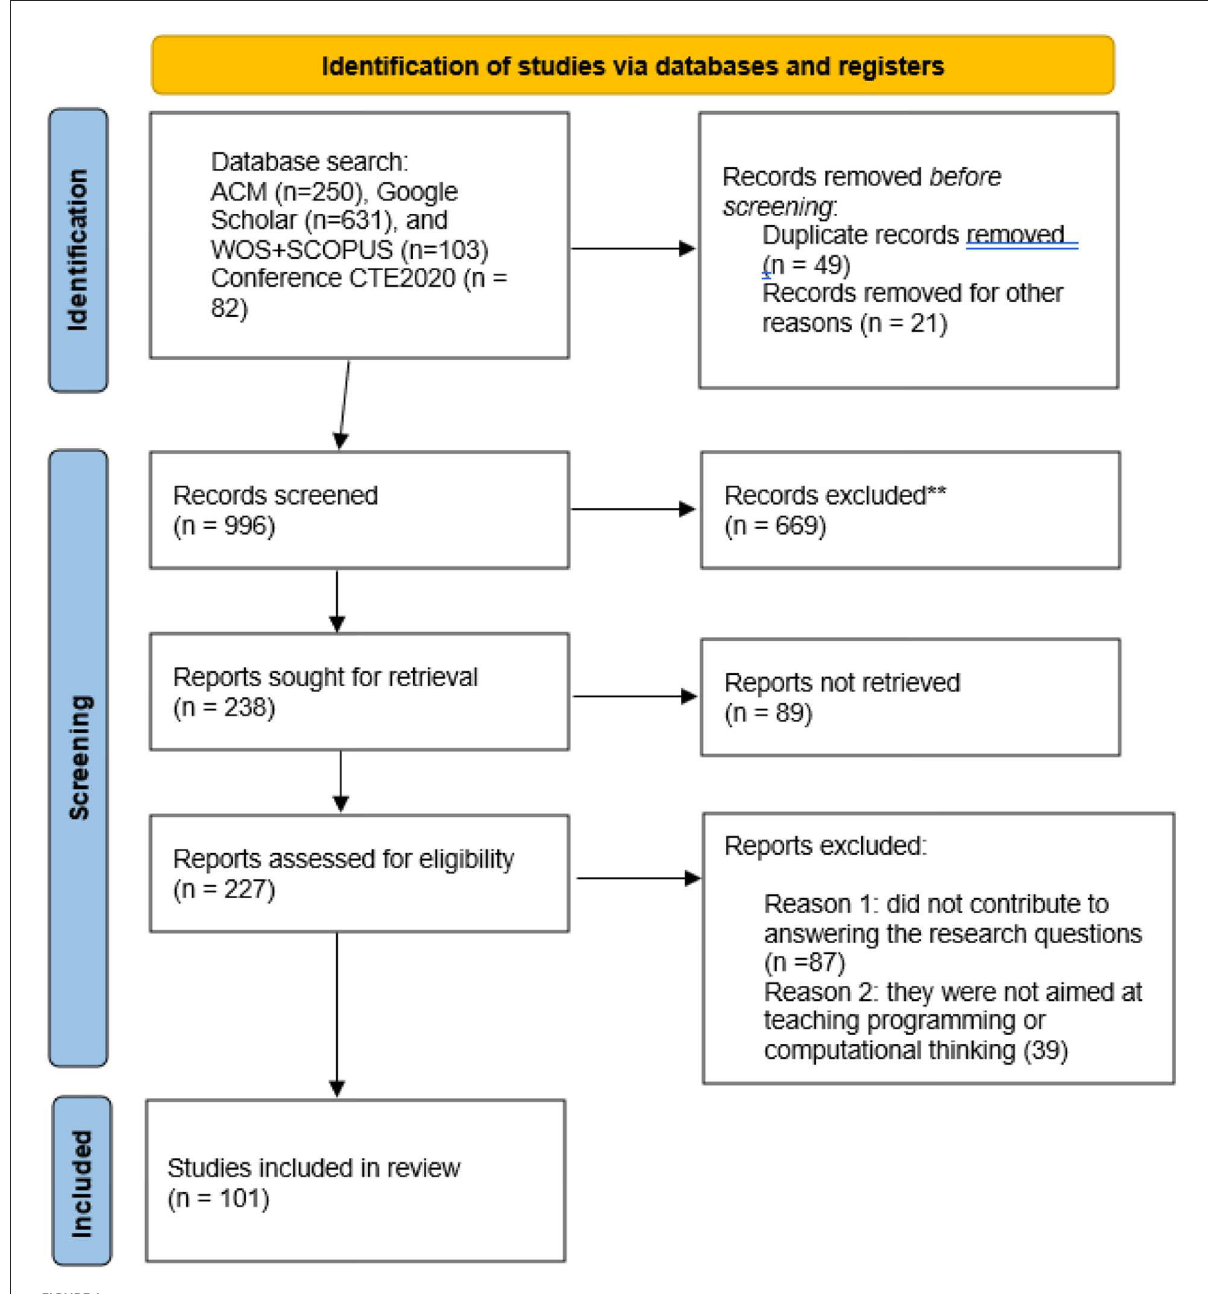
FIGURE1 Own elaboration based on the literature search procedure according to the PRISMA